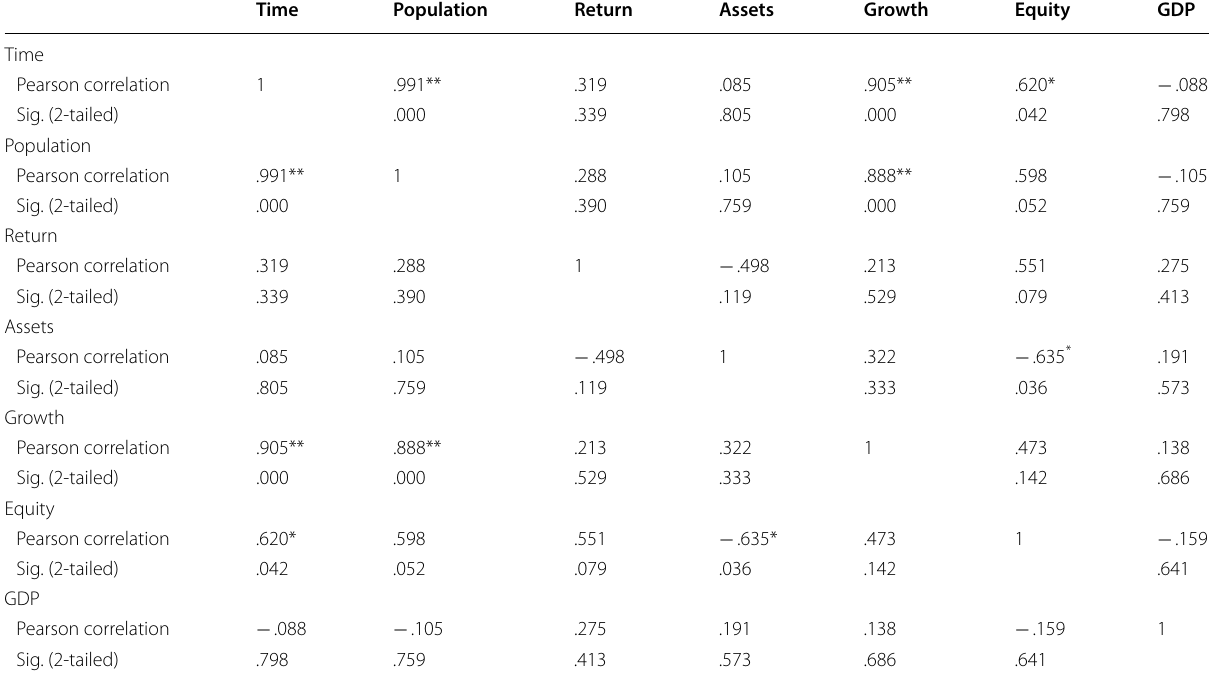
*Correlation is significant at the .05 level (2-tailed) **Correlation is significant at the .01 level (2-tailed)